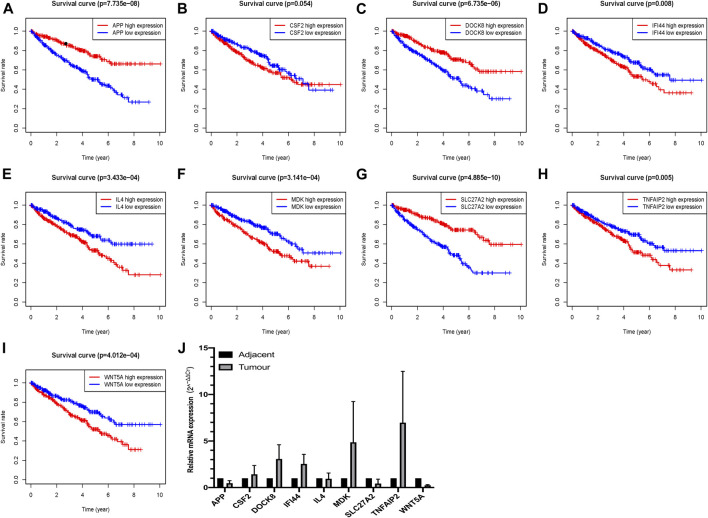
Verification of the expression and prognostic significance of nine critical apoptosis-related genes in ccRCC; (A)Survival analysis of APP; (B) Survival analysis of CSF2; (C) Survival analysis of DOCK8; (D) Survival analysis of IFI44; (E) Survival analysis of IL4; (F) Survival analysis of MDK; (G) Survival analysis of SLC27A2; (H) Survival analysis of TNFAIP2; (I) Survival analysis of WNT5A; (J) qRT-PCR verification of these nine critical apoptosis-related genes in ccRCC.